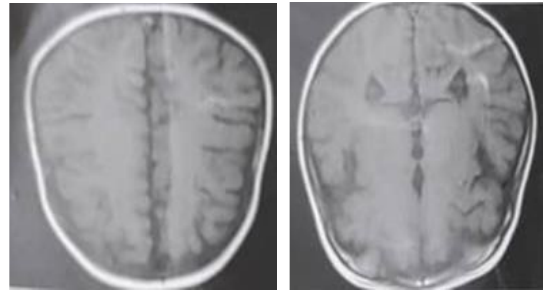
Figure 2 . Brain Magnetic Resonance Imaging of the Patient, Showing Polymicrogyria and Simplified Gyrus of the Cerebral